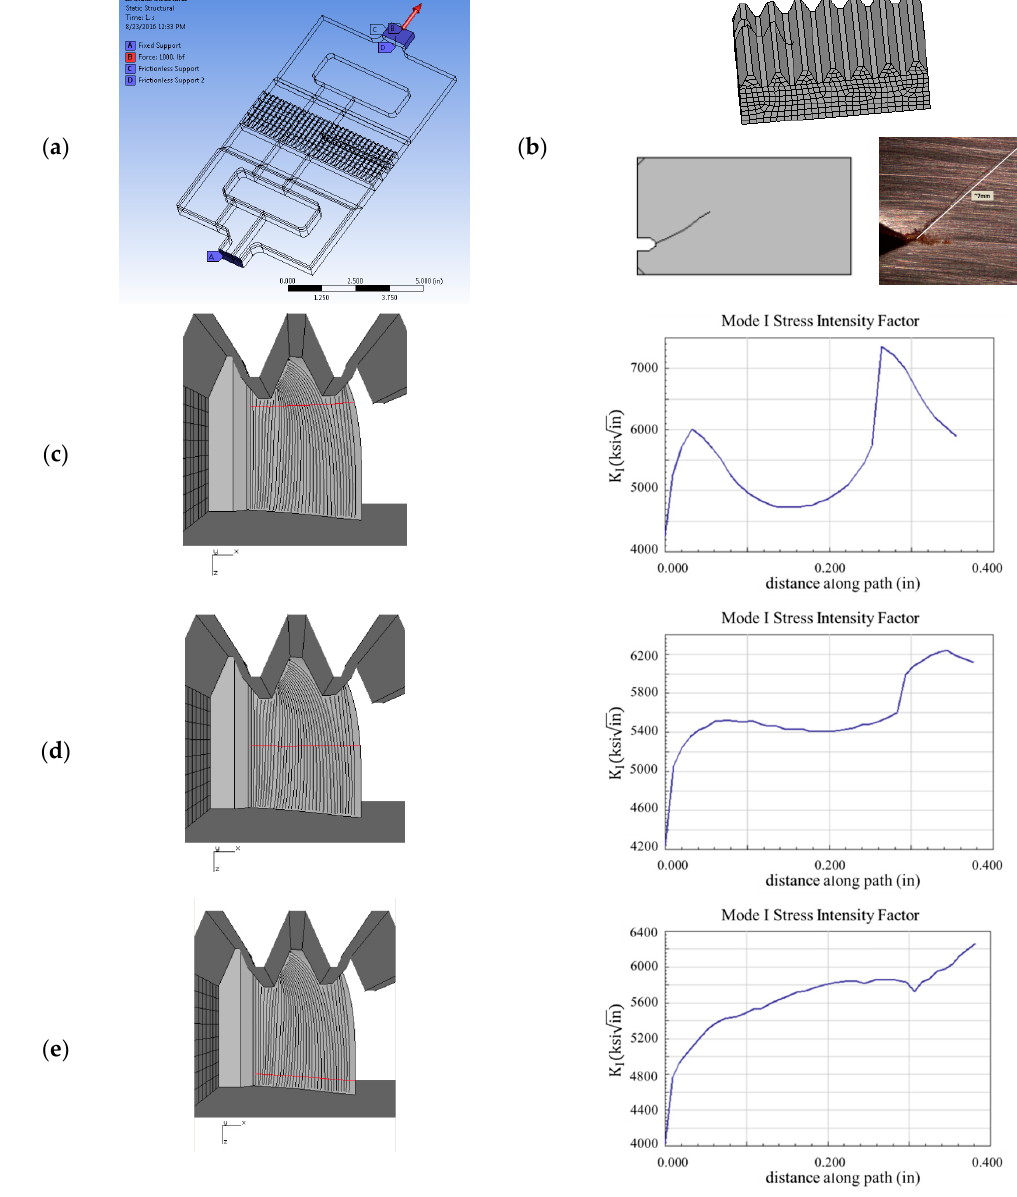
Figure 6. The Franc3D model and the predicted crack growth rate ( a ) sample model; ( b ) mesh around the notch tip, crack direction in the model and experiment; ( c – e ) crack lines along different crack surfaces and corresponding SIFs.